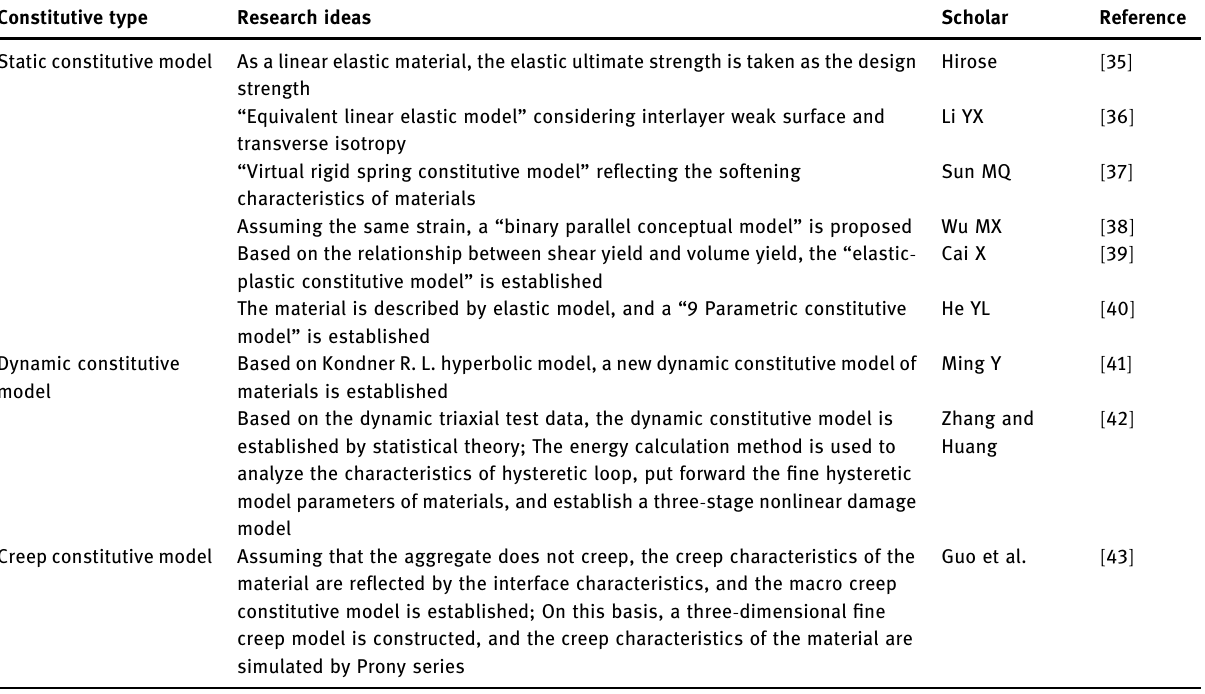
Table 6: Research progress of constitutive model of CSG Constitutive type Research